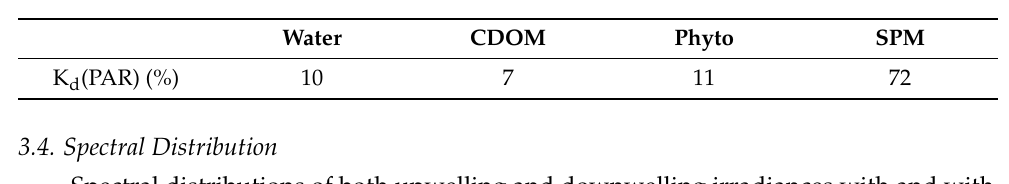
Table 2. Partitioning (%) of K d (PAR) relative to the optical constituents-water, CDOM, phytoplankton, and suspended particulate matter.